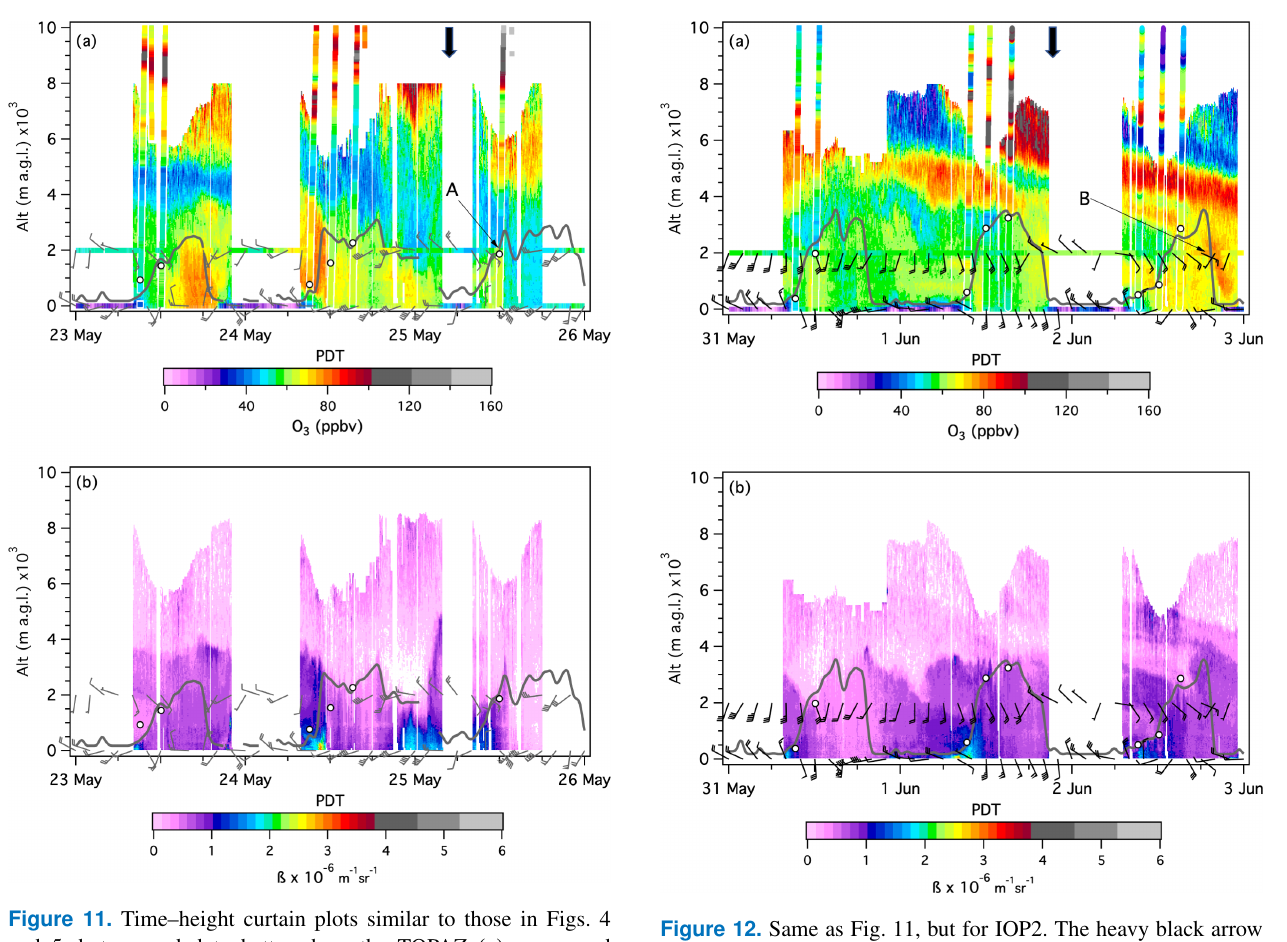
Figure 12. Same as Fig. 11, but for IOP2. The heavy black arrow corresponds to the 06:00UT 2 June 300hPa plot in Fig.